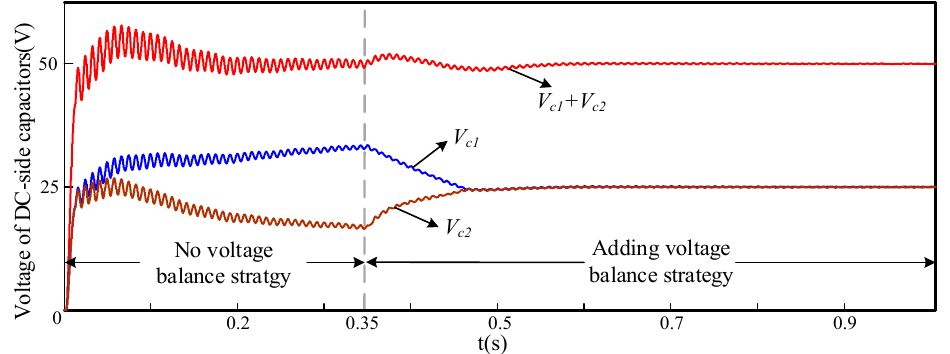
Figure 8. The waveform of capacitors’ voltage on DC-link .